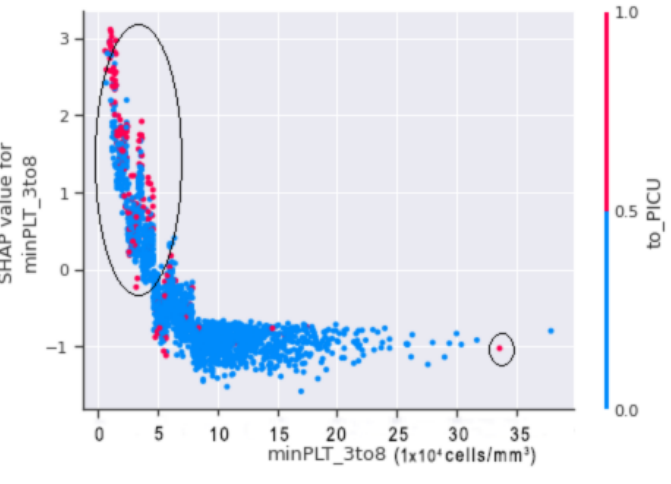
Figure 16. SHAP dependence plot of minPLT_3to8 and to_PICU illustrating minPLT_3to8 along horizontal axis and to_PICU along vertical axis.